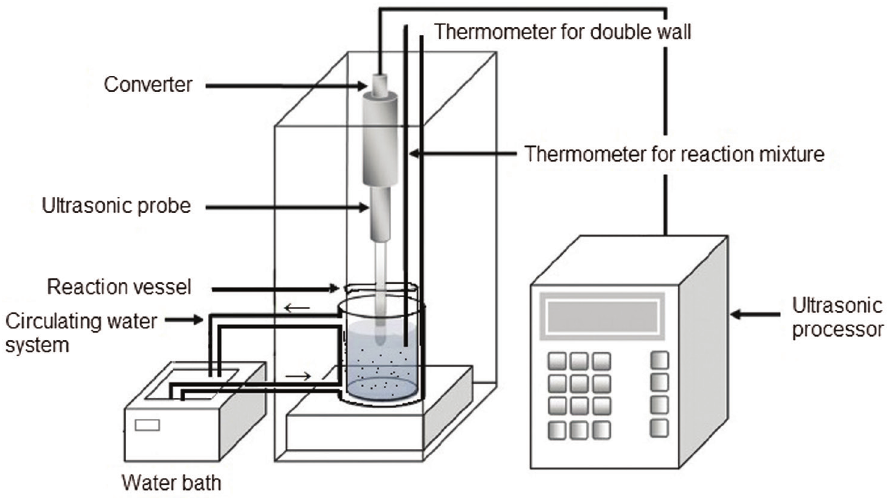
Figure 1: The scheme of ultrasonic reactor with simultaneous cooling